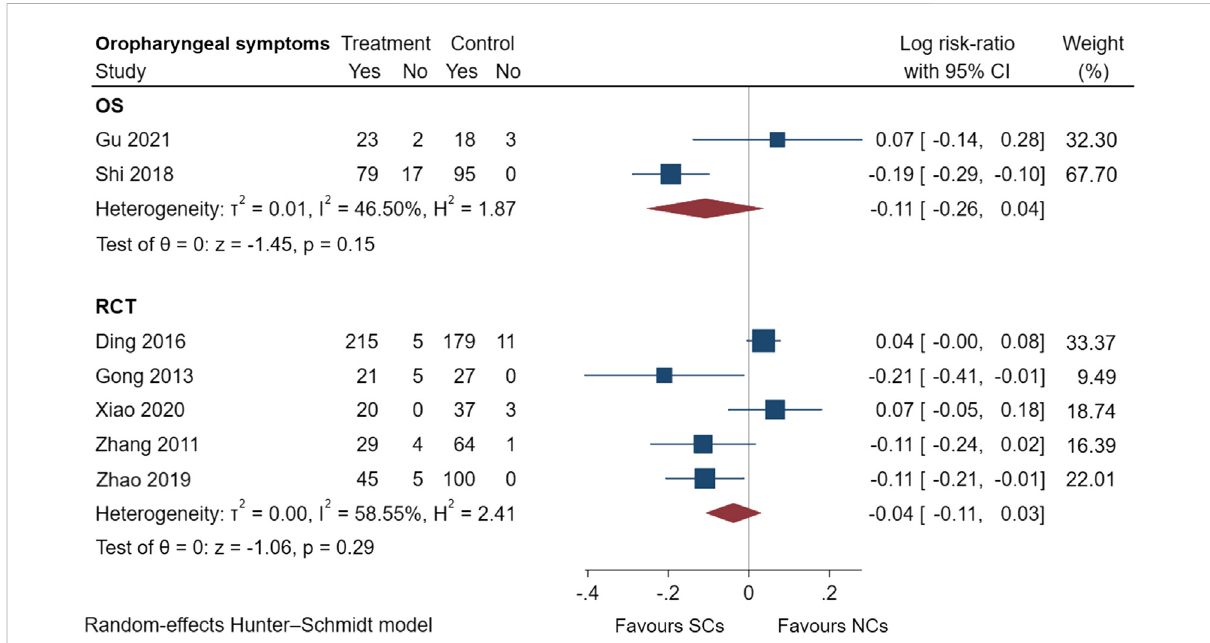
Oropharyngeal symptoms of SCs and NCs in observational studies and randomized controlled